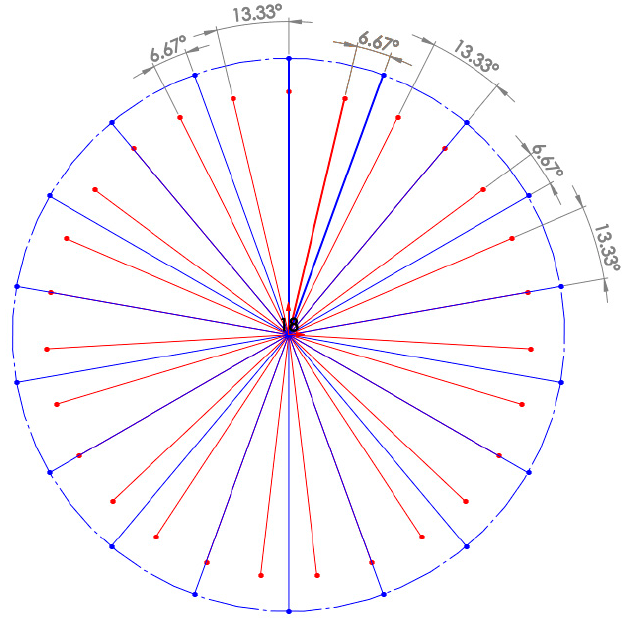
Figure 17. The phase difference of the 1st stage stationary blade and moving blade.